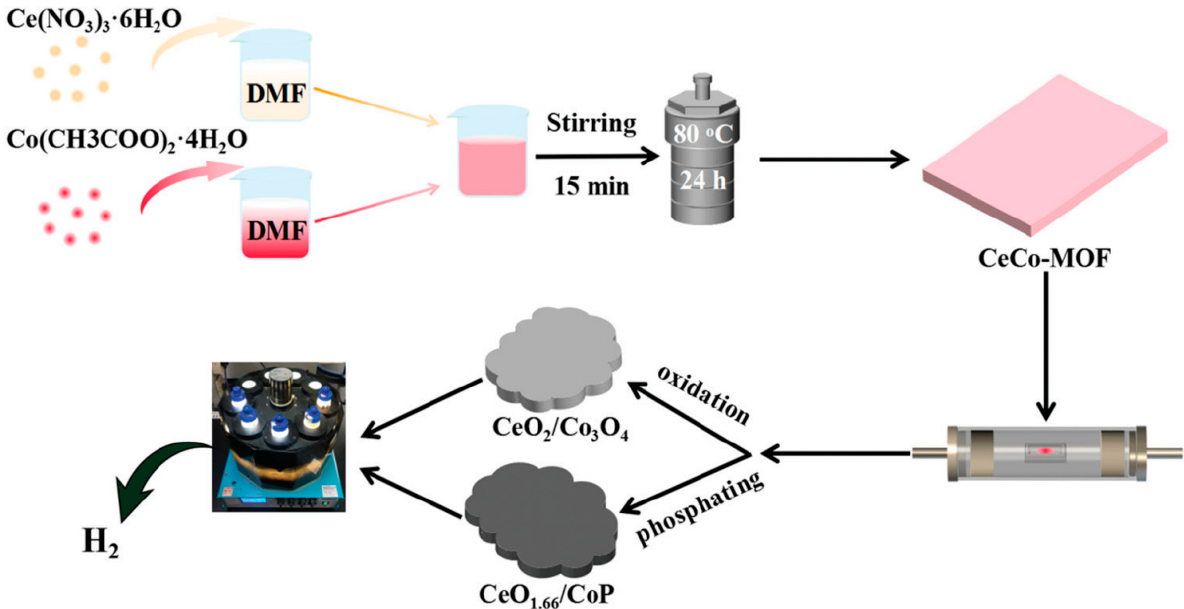
Figure 21. The preparation diagram of the CeO 1.66 /CoP and CeO 2 /Co 3 O 4 catalysts. Reproduced with permission from Ref. [89].